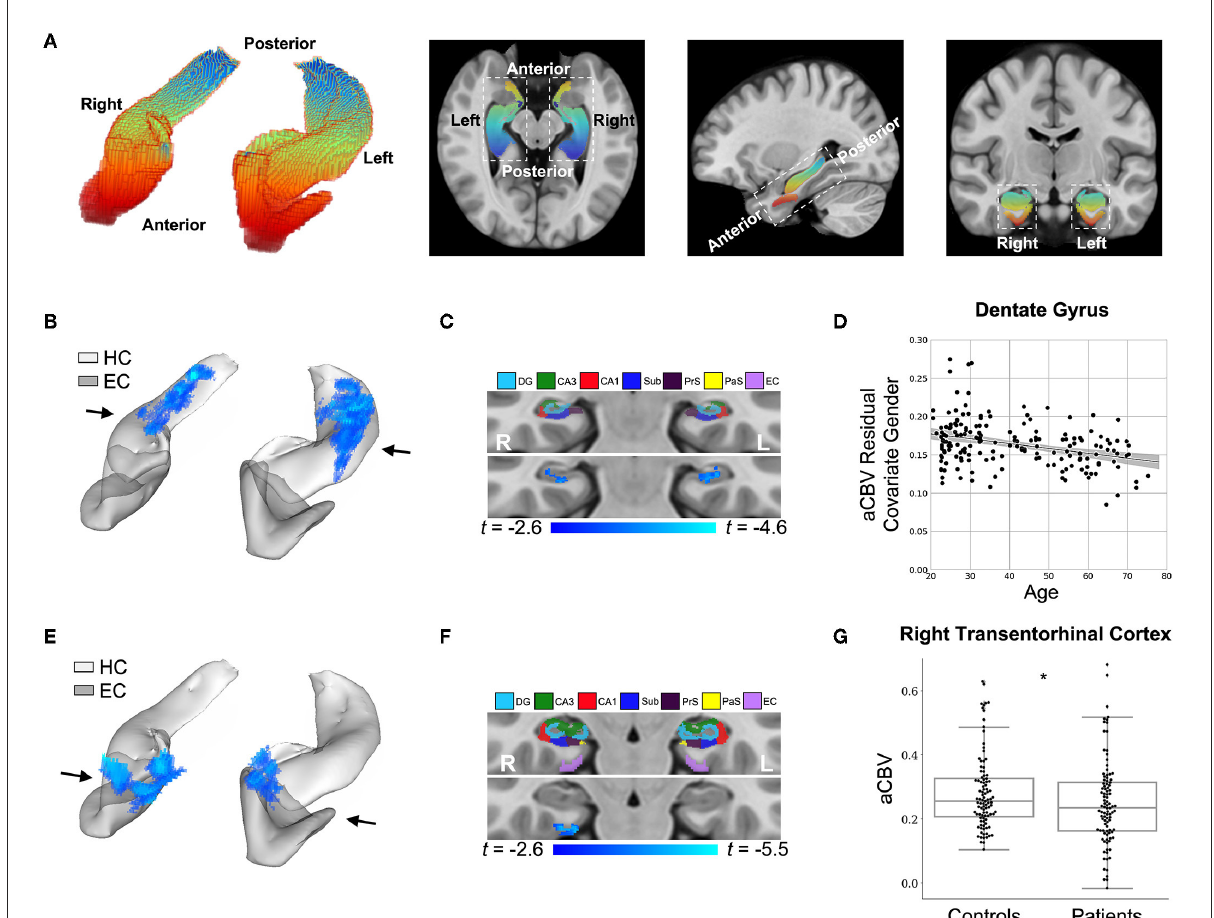
FIGURE4 DeepContrast maps differential anatomical patterns of dysfunction in the hippocampal formation. (A) A three-dimensional rendering of the bilateral hippocampal formation (left panel) consisting of the hippocampus (HC) and the entorhinal cortex (EC) and axial, sagittal, and coronal slices from a group-wise T1-weighted MRI template cutting through the hippocampal formation (right three panels). The hippocampal formation is displayed along the anterior-to-posterior axis. (B) A voxel-based analysis of the synthesized CBV maps of 177 individuals ranging from 20 to 72 years of age reveals that the greatest age-related decline occurred in the body of the hippocampal circuit (color-coded by the degree of significance). (C) A coronal slice, onto which the hippocampal formation mask is applied, reveals that age-related decline primarily localizes to the dentate gyrus. The voxel-based analysis is conducted using a multiple regression model in SPM12 using sex as a covariate and age as the regressor, and the age-related differences are contrasted using Student’s t test. Multiple comparisons are corrected for, yielding voxel-wise p < 0.005 and cluster-wise p < 0.05 (refer to methods). (D) A scatter plot shows the association between age and mean synthesized CBV values in the dentate gyrus after the removal of gender effects ( β age = − 6.36e-4, t age = − 4.64, p age = 6.85e-6). The shaded area surrounding the regression line indicates the 95 % CI. (E) A voxel-based analysis of the synthesized CBV maps of 50 Alzheimer’s disease (AD) patients compared with 50 age-matched normal controls, each with two back-to-back scans, reveals AD-related reduction in the entorhinal cortex (color-coded by the degree of significance). (F) A coronal slice, onto which the hippocampal formation mask is applied, reveals that AD-related decline localizes primarily to the transentorhinal cortex. The voxel-based analysis is conducted using a multiple regression model in SPM12 using age, sex, and participant identity as covariates and diagnostic class (i.e., cognitive normal vs. dementia) as the regressor and the AD-related difference are contrasted using Student’s t -test. Multiple comparisons are corrected for, yielding voxel-wise p < 0.005 and cluster-wise p < 0.05 (refer to methods). (G) A box plot showing individual-participant mean synthesized CBV values in the right transentorhinal cortex indicates a significant difference between patients with Alzheimer’s disease and healthy controls (two sample t -test one-tailed p = 0.031). Center line: median; box limits: upper and lower quartiles; whiskers: 1.5 × interquartile range; points: outliers. HC: hippocampus; EC: entorhinal cortex; DG: dentate gyrus; CA3: cornu Ammonis 3; CA1: cornu Ammonis 1; Sub: subiculum; Prs: presubiculum; PaS: